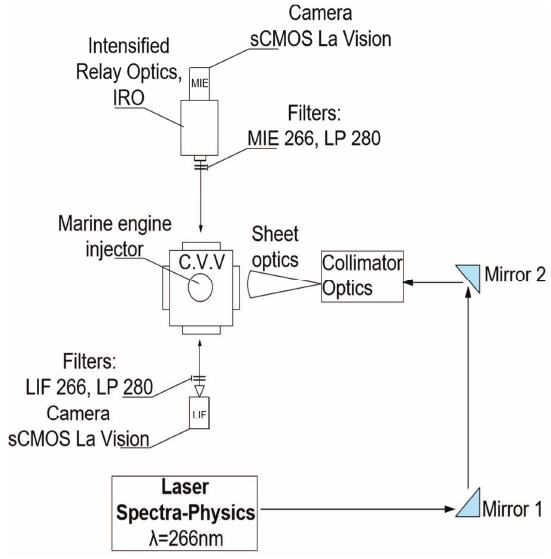
Fig. 3. Experimental setup of the LIF/Mie optical arrangement, C.V.V – Constant Volume Vessel